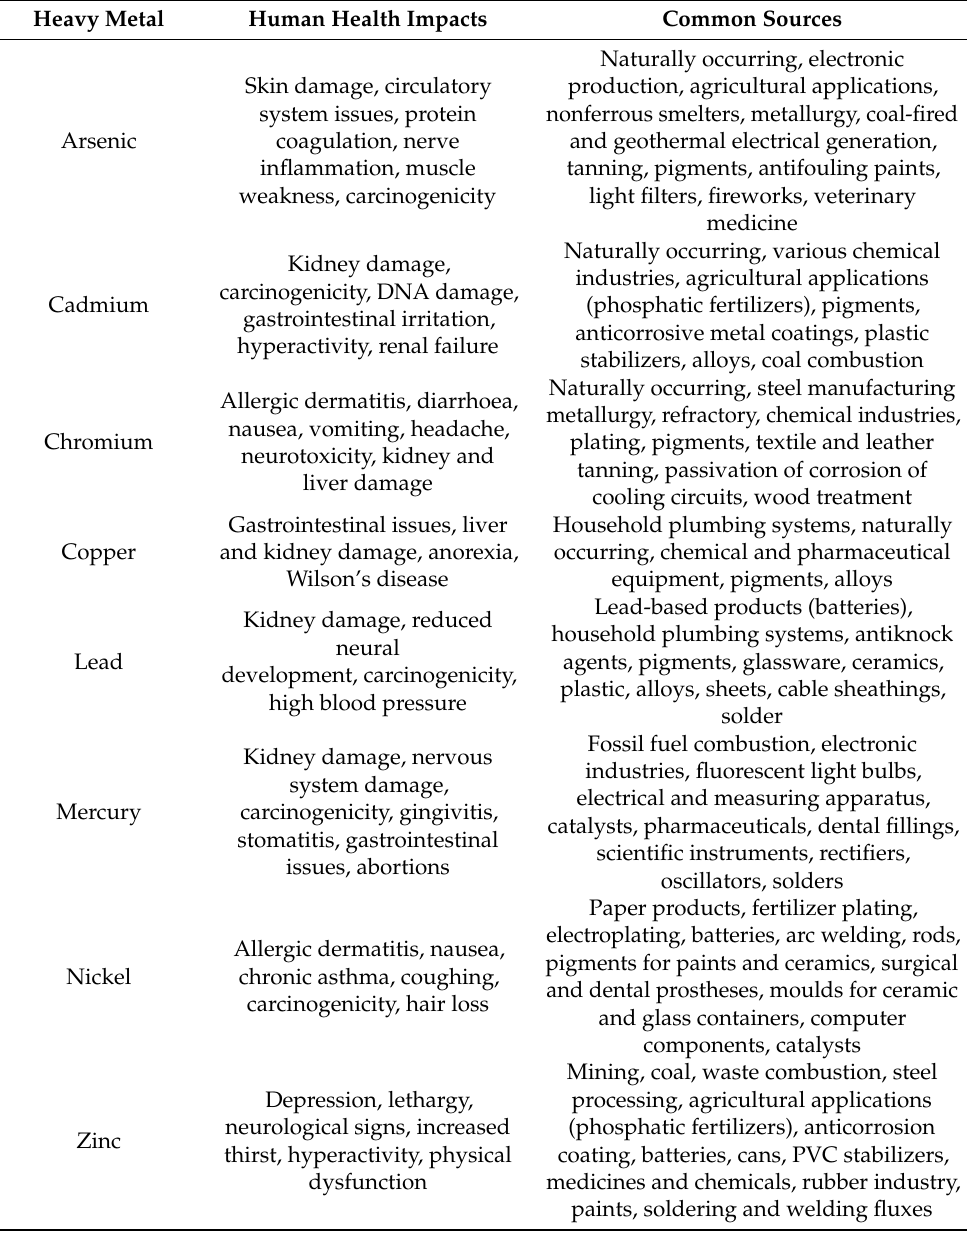
Table 2. Heavy metal characteristics